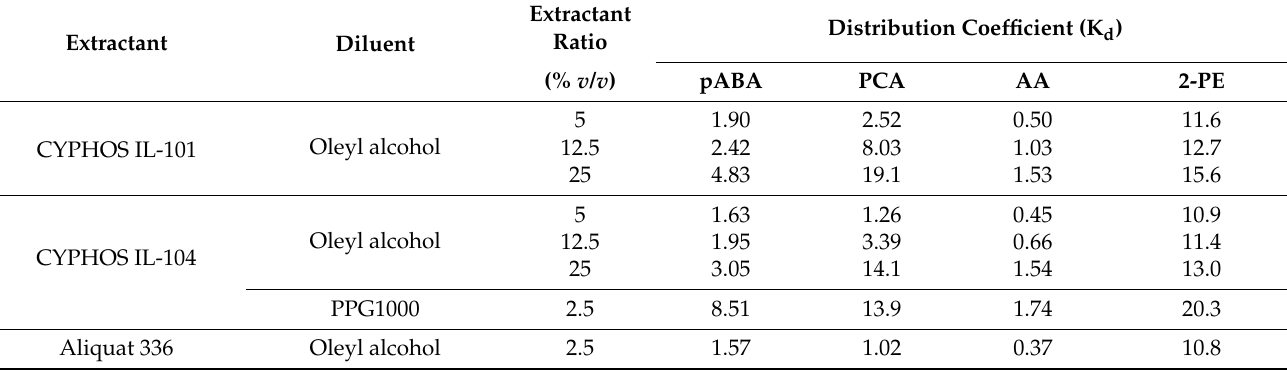
Table 3. Distribution coefficients of the most promising biocompatible solvent mixtures for reactive extraction of para - aminobenzoic acid (pABA), protocatechuic acid (PCA), adipic acid (AA), and 2-phenylethanol (2-PE).